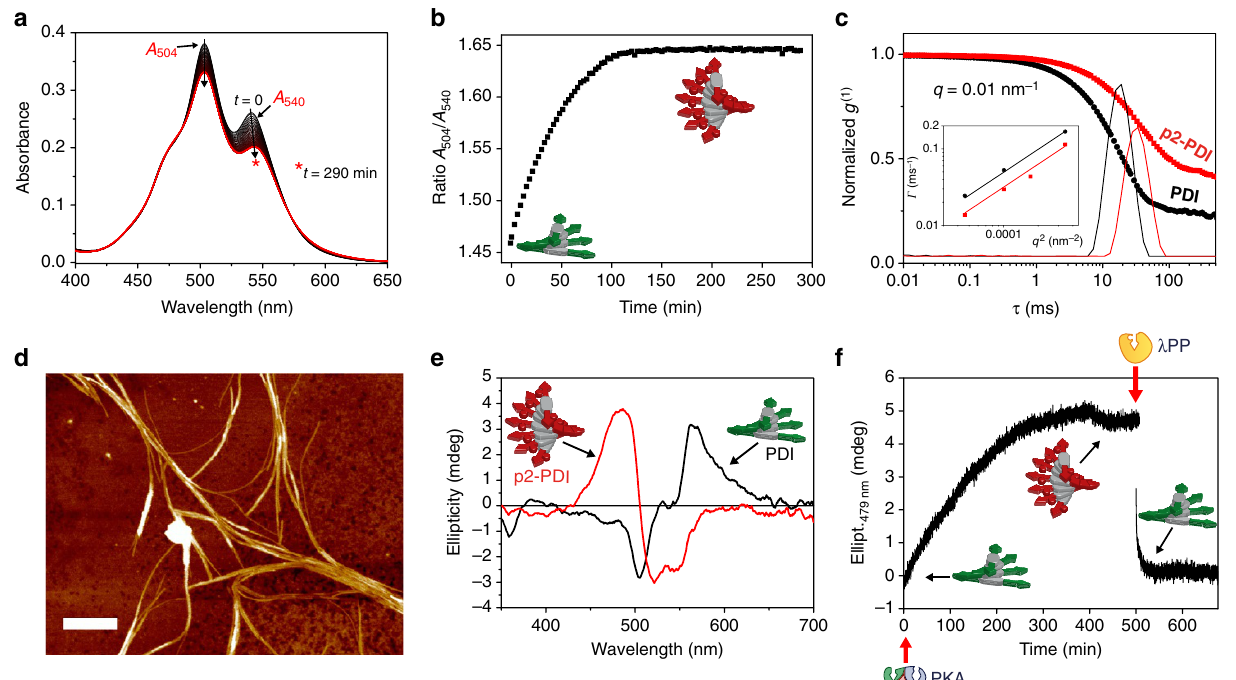
Figure 2 | Changes in the supramolecular polymer induced by (stepwise) phosphorylation. ( a ) Ultraviolet–visible spectra of a 200 m M PDI solution (optical path 1mm) during phosphorylation triggered by the addition of PKA (0.13 m M) and ATP (400 m M), showing the evolution of the two main peaks ( A 504nm , A 540nm ) (black arrows). ( b ) Time-course A 504nm /A 540nm during phosphorylation, extracted from spectra in a . ( c ) DLS measurements: normalized crosscorrelation function ( g (1) ( t )) of 1mM PDI (black dotted line) and p2-PDI (red dotted line) solutions, showing a shift to higher lag-time t upon phosphorylation. The corresponding distribution of the relaxation times for PDI (black solid line) and p2-PDI (red solid line). The insert: relaxation G versus the square of the scattering vector q 2 . ( d ) Atomic force microscopy (AFM) image of 2 m M p2-PDI drop cast on mica. Scale bar, 500nm. ( e ) CD spectra of 200 m M PDI (black line) and p2-PDI (red line) solutions (optical path 1mm). ( f ) Time-course CD measurements (ellipticity at 479nm versus time) of a 200 m M PDI solution during stepwise phosphorylation/dephosphorylation (optical path 1mm, 400 m M ATP, 0.13 m M PKA, followed by 0.3 m M l PP at t ¼